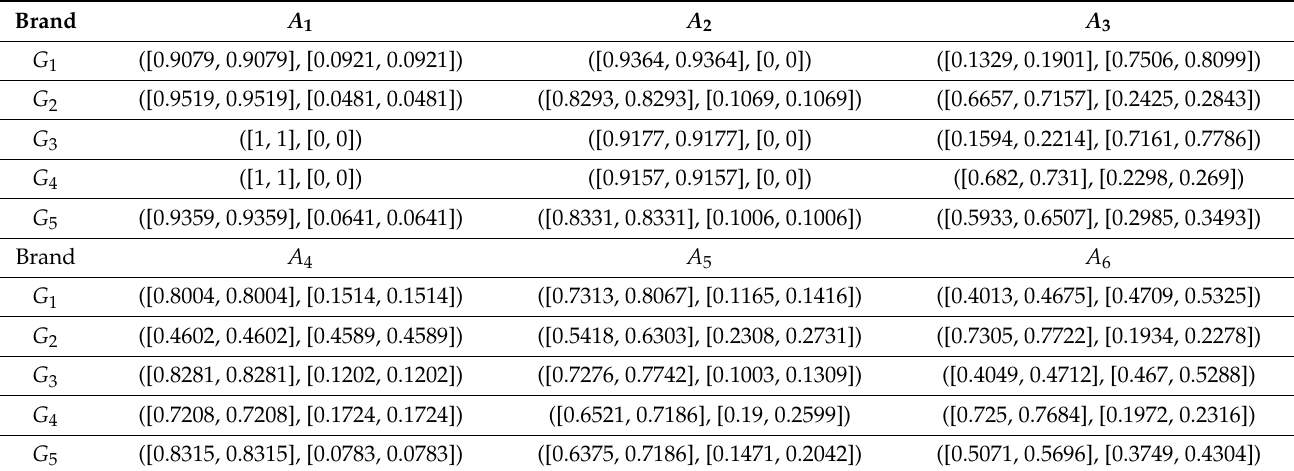
Table 11. The group comprehensive evaluation matrix.